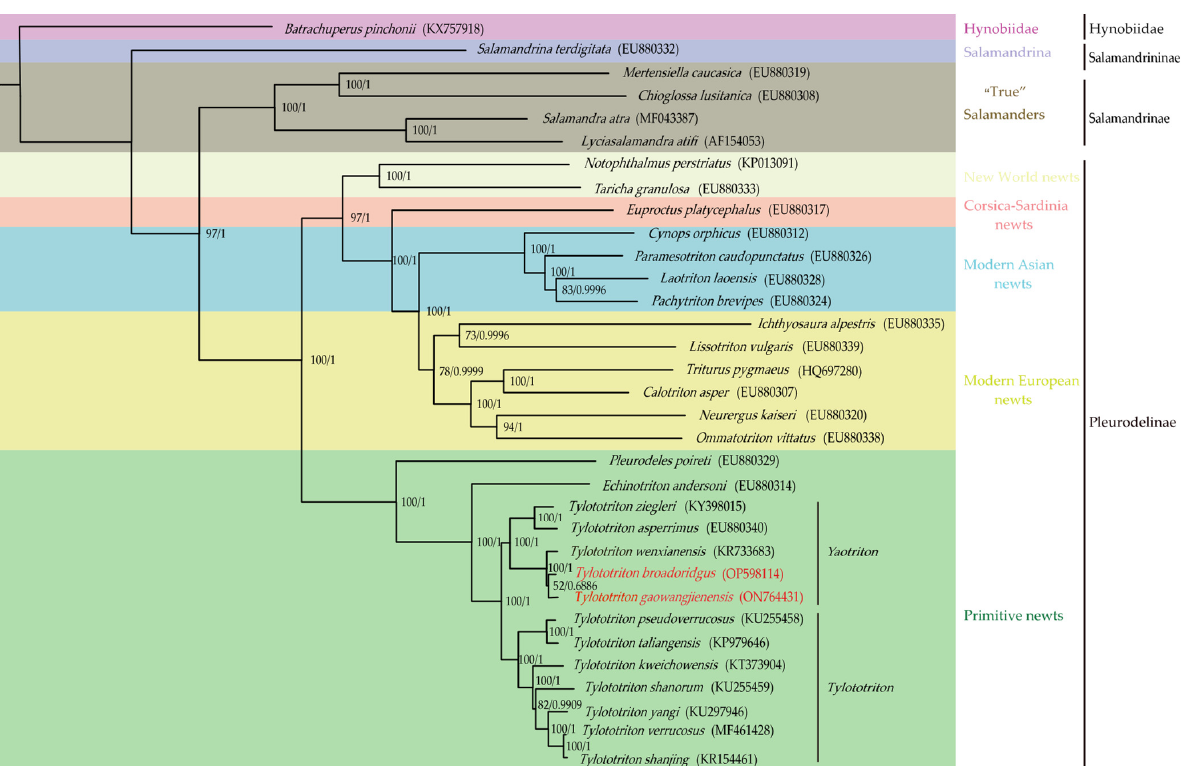
Figure 5. Phylogenetic relationships within Salamandridae derived from ML method based on 13 PCGs. Note: Names in red show the phylogenetic positions of T. broadoridgus and T. gaowangjienensis that we sequenced in this study. The numbers on the nodes are the bootstrap values and posterior probabilities from ML and BI methods. The GenBank accession number of each species is given in the bracket after the species name.